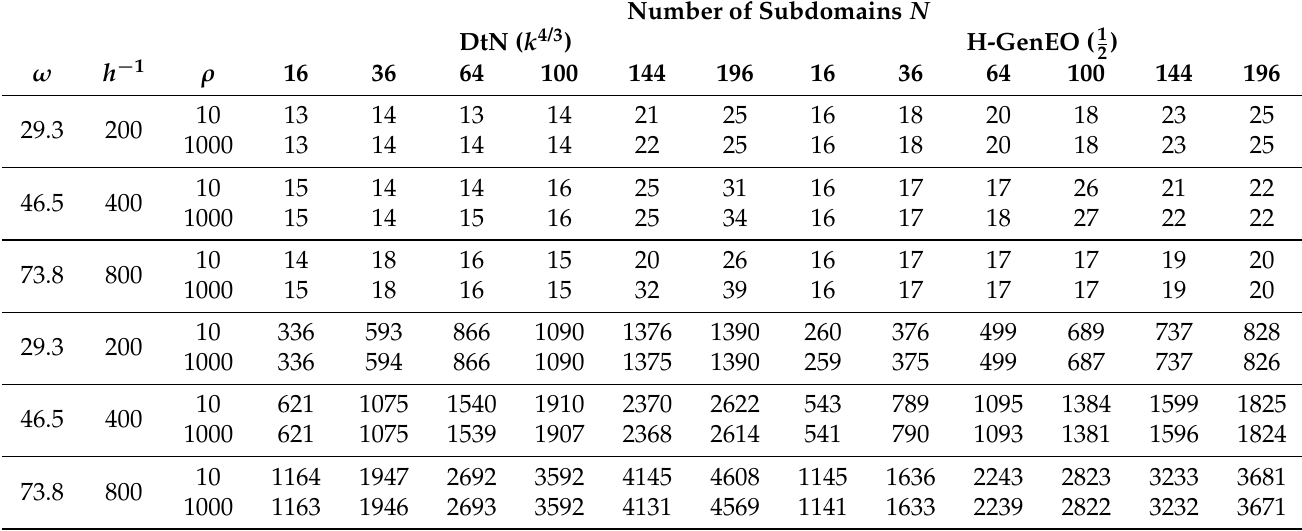
Table 6. Preconditioned GMRES iteration counts (above) and size of coarse space (below) for the heterogeneous diagonal layers problem when using ORAS with DtN( k 4/3 ) or H-GenEO( 1 varying number of subdomains. A uniform decomposition into is used.